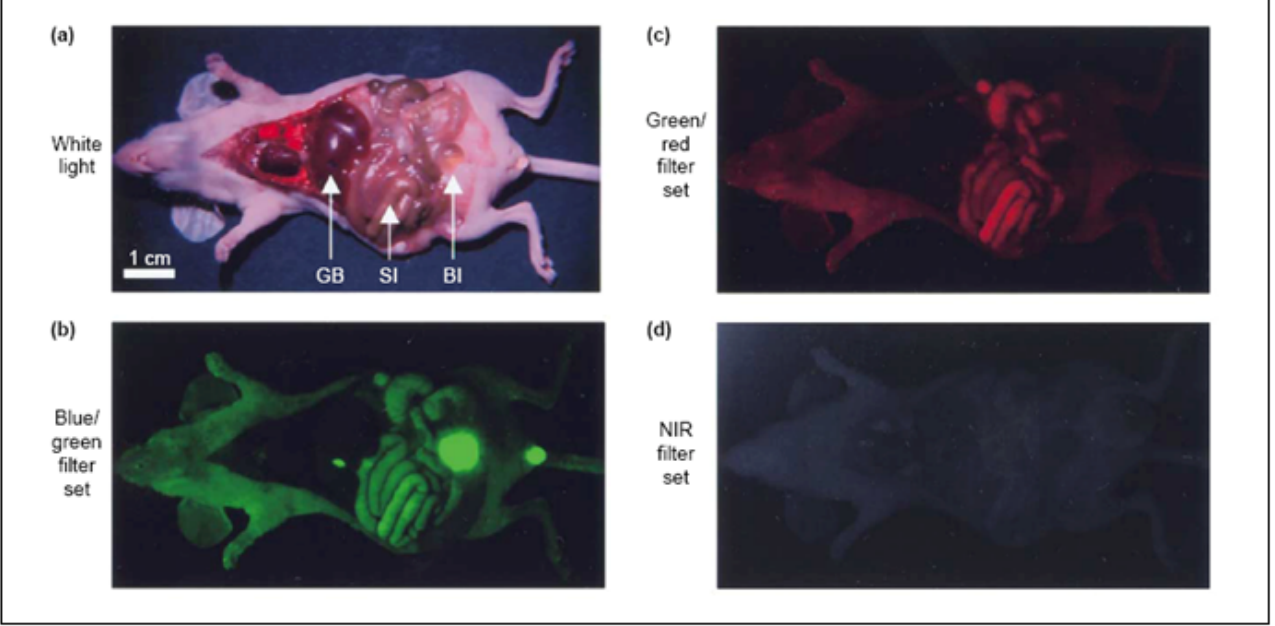
Figure 1. Wavelength-dependent autofluorescence of vital organs and body fluids. ( a ) Image of the viscera of an athymic nude mouse taken immediately after sacrifice. The arrows indicate the location of gall bladder (GB), small intestine (SI) and bladder (Bl). Tissue autofluorescence was imaged using three different excitation/emission filter sets; ( b ) blue/green (460–500 nm/505–560 nm); ( c ) green/red (525–555 nm/590–650 nm); and